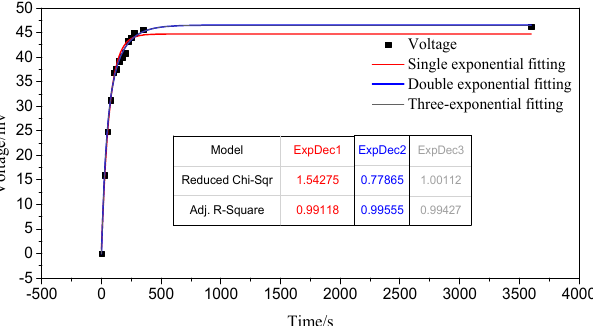
Figure 2. Coe ffi cient fitting of exponential Figure 2. Coefficient fitting of exponential curves. Figure 2. Coefficient fitting of exponential curves.